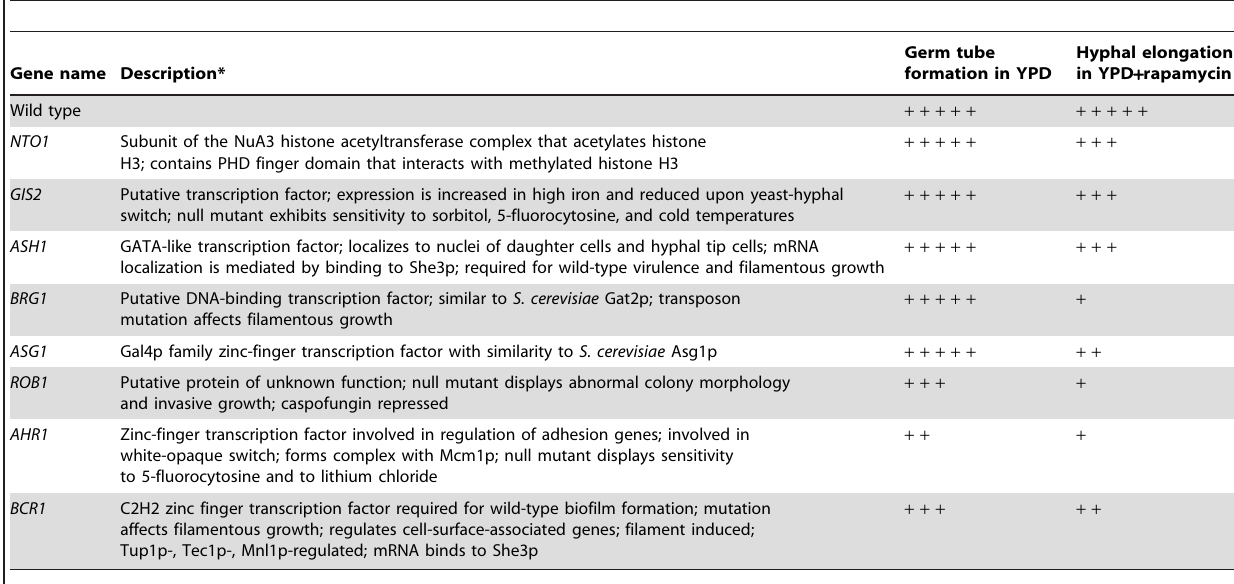
Table 1. Transcription factor mutants defective in hyphal maintenance in